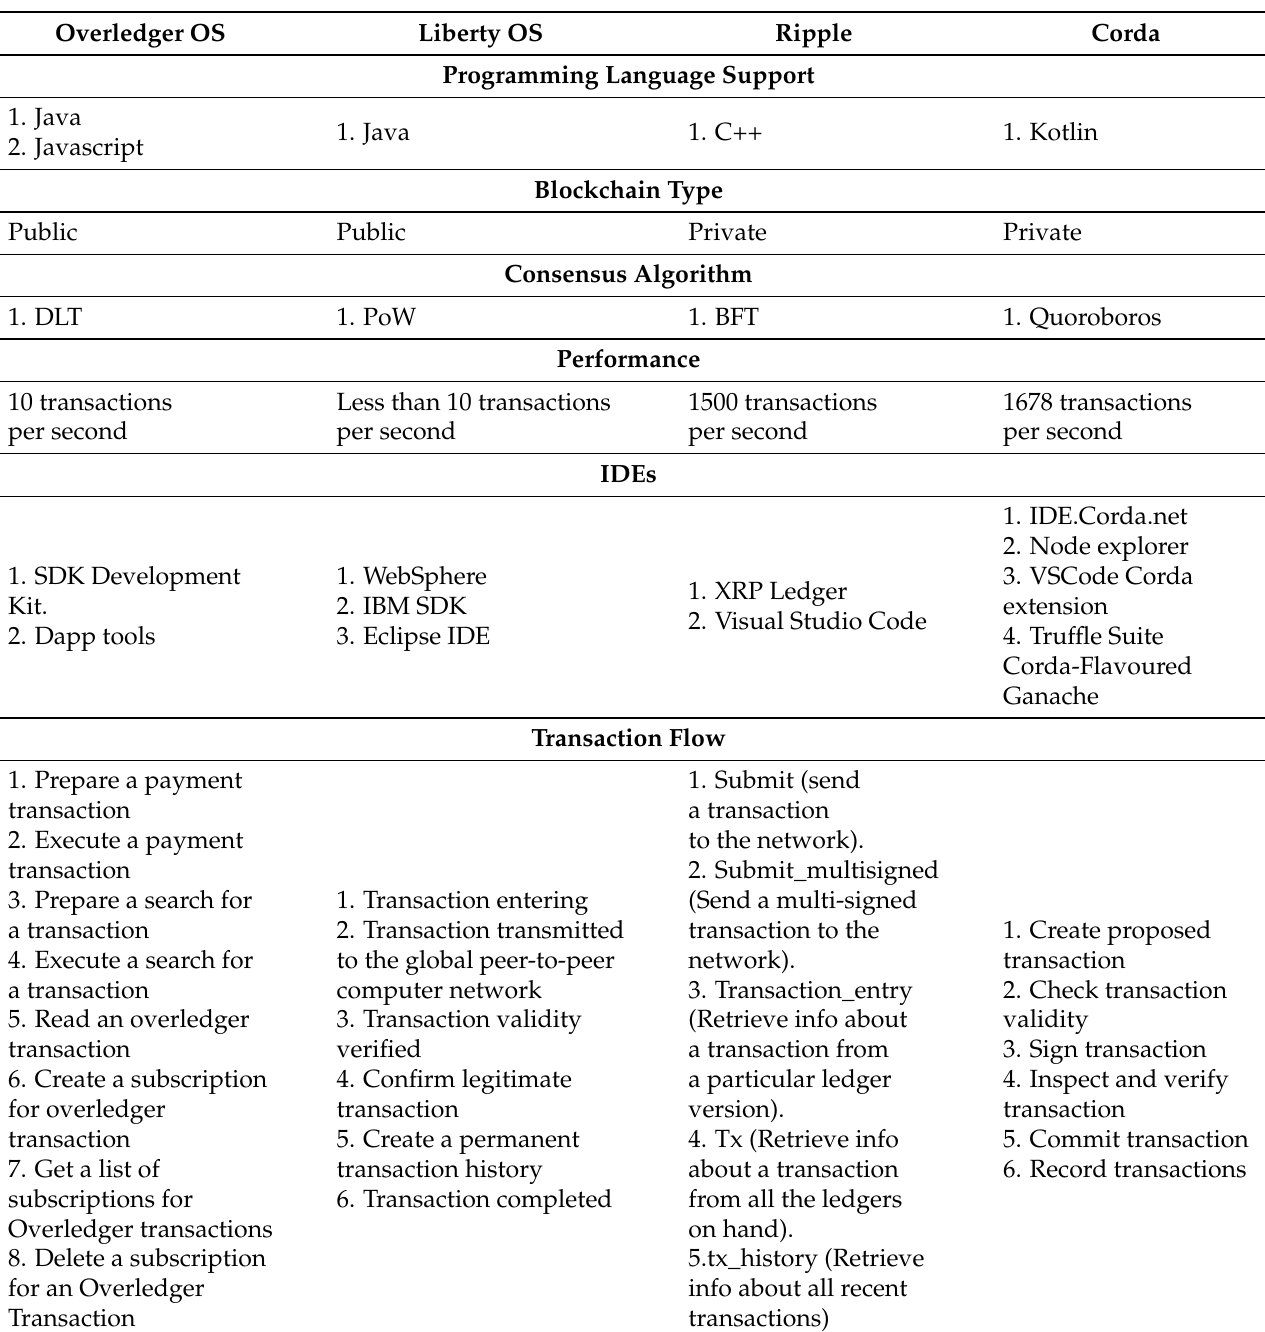
Table 4. A comparison of blockchain operating systems and their related